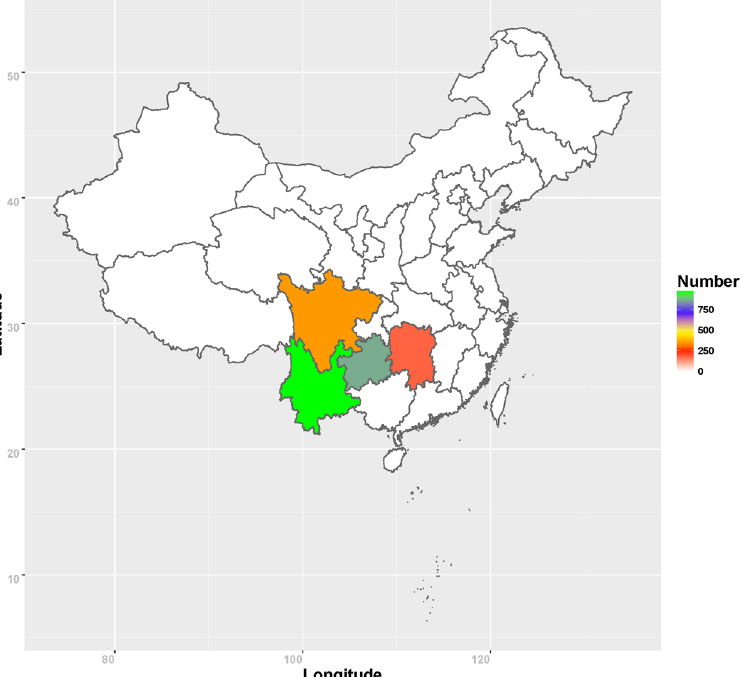
Figure 1. Study areas and geographic distribution of new leprosy cases in southwest China between January 2010 and June 2014. Study areas include four provinces, Yunnan, Guizhou, Sichuan and Hunan, corresponding to pale green, dark green, orange and red colour in southwest China. Green = the most patients, red = the least patients. The map in this figure was generated by means of software R, including maptools, maps and mapdata (Version 3.3.3,